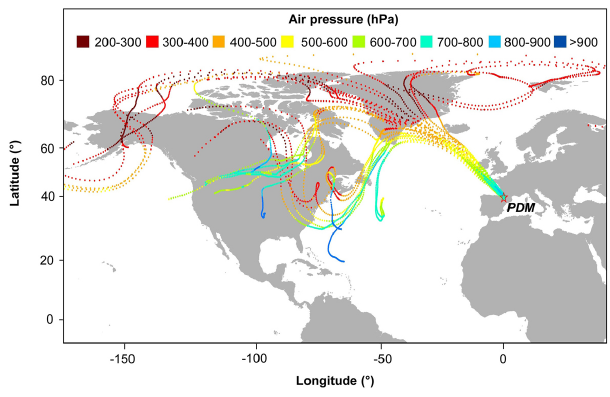
Figure 6. 168h Hysplit air mass backward trajectories for the typ- ical high GOM event #7. To reduce the uncertainty related to tra- jectory simulations (Sexauer Gustin et al., 2012), trajectories were calculated for 27 locations evenly-distributed in a 0.5 ◦ × 0.5 ◦ grid cell and at a height of − 500, 0, and 500m around the PDM Obser- vatory.